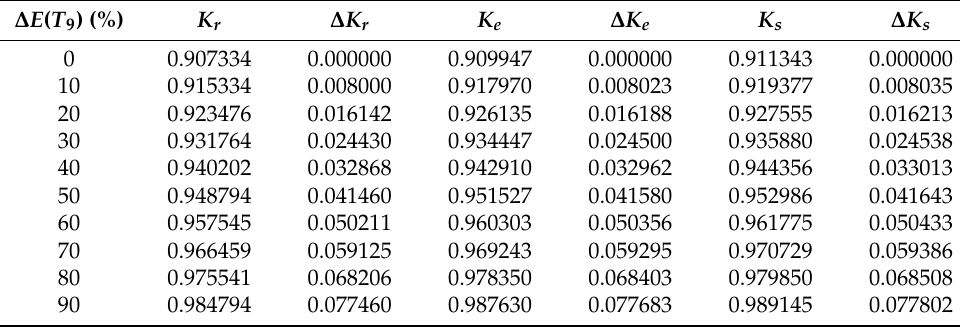
Table 9. Indicators values obtained in sensitivity analysis of